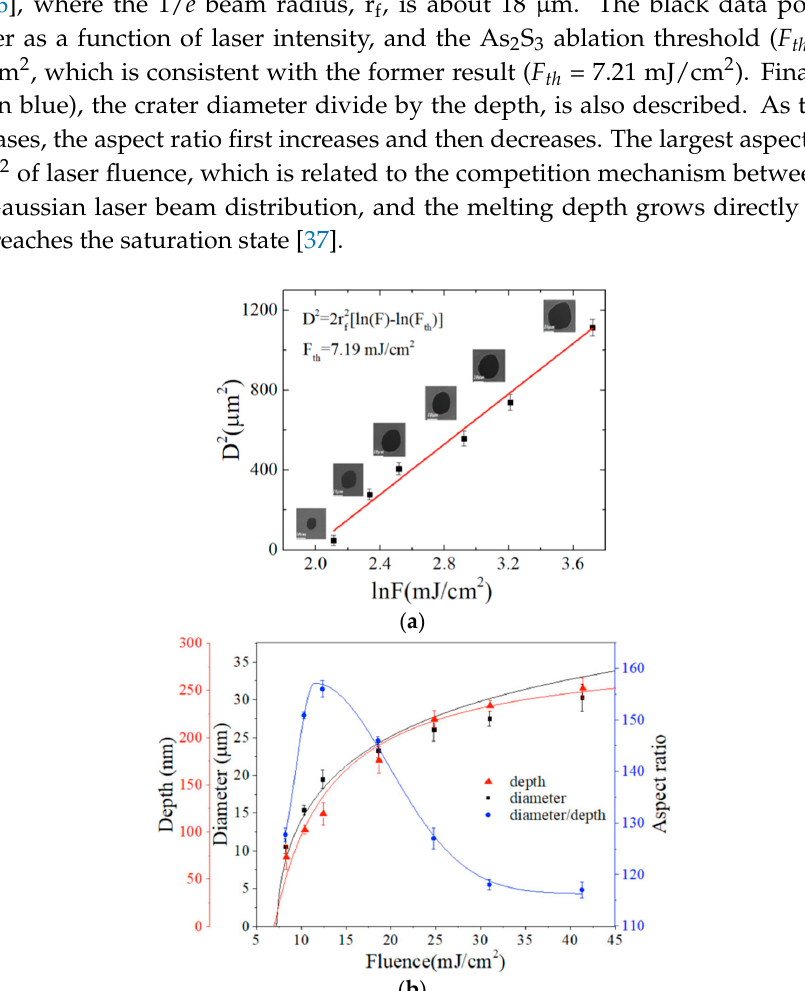
Figure 2. ( a ) The ablation diameter of r a 2 , versus the laser fluence ln( F ). ( b ) The data points in red, black and blue indicate the hole depth, the diameter and the corresponding aspect ratio, respectively, the red solid curve, the black solid curve and the blue solid curve show the calculated hole depth, the diameter and the aspect ratio using a 150-fs pulse duration laser, respectively.